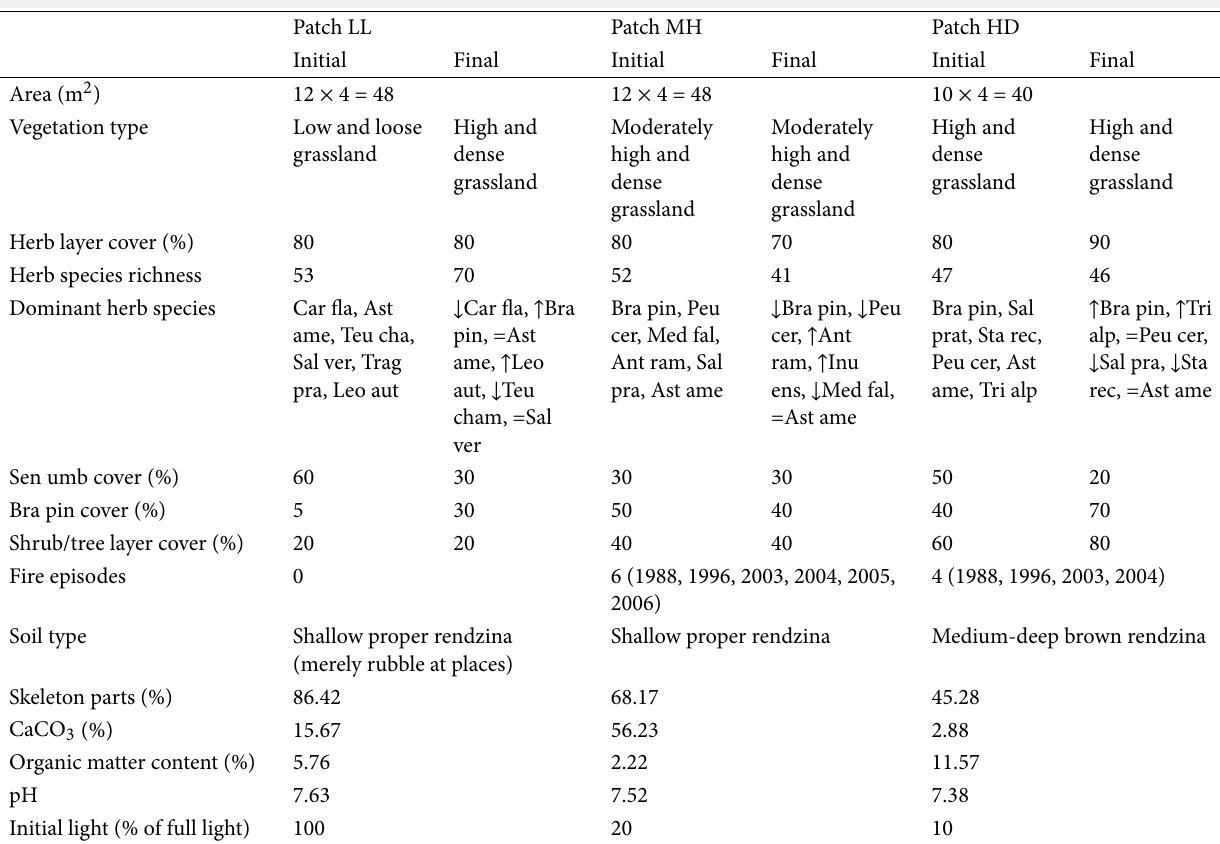
Table 1 Characteristics of the study patches in the Senecio umbrosus